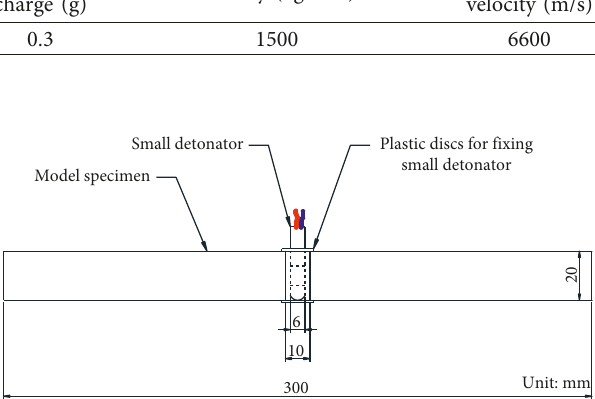
Figure 11: Charging structure diagram of the transparent model specimen.